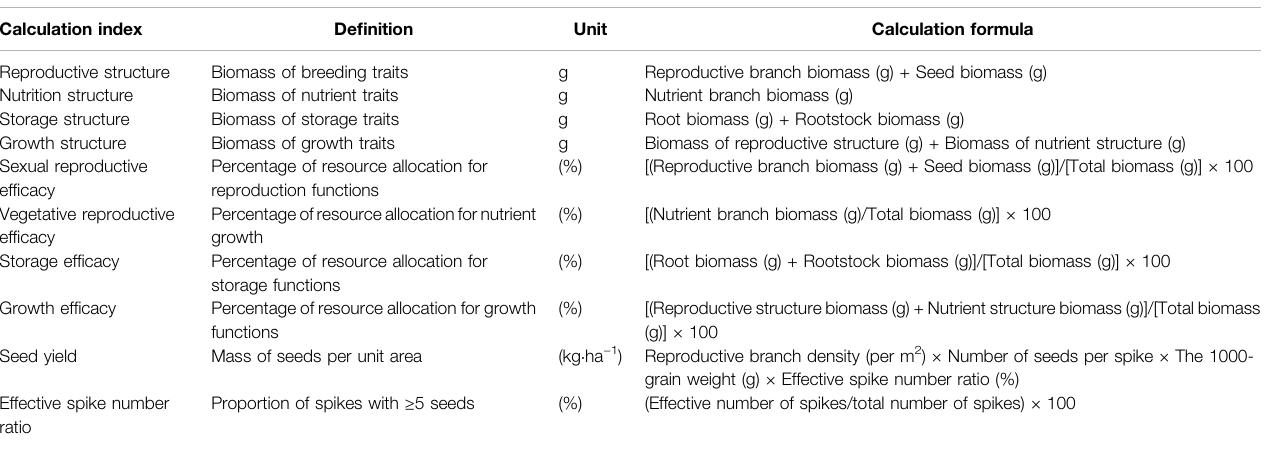
TABLE 3 | De fi nition of different plant indicators and their calculation